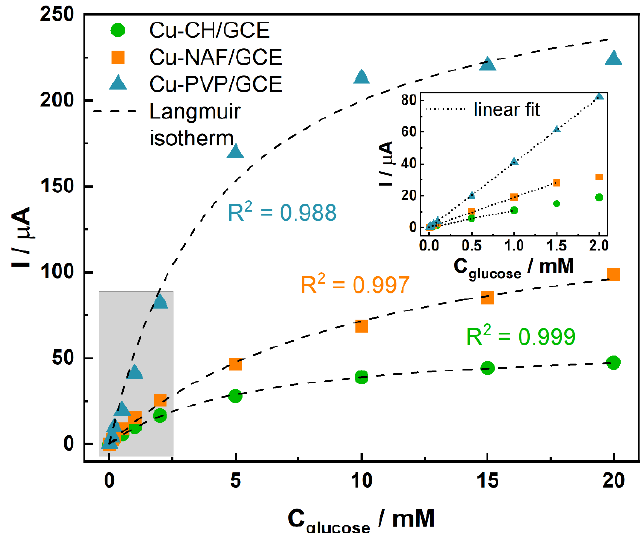
Figure 6. Amperometric response of modified electrodes to increasing glucose concentrations with fitted Langmuir isotherms. The inset shows the linear response range of the electrodes with fitted regression